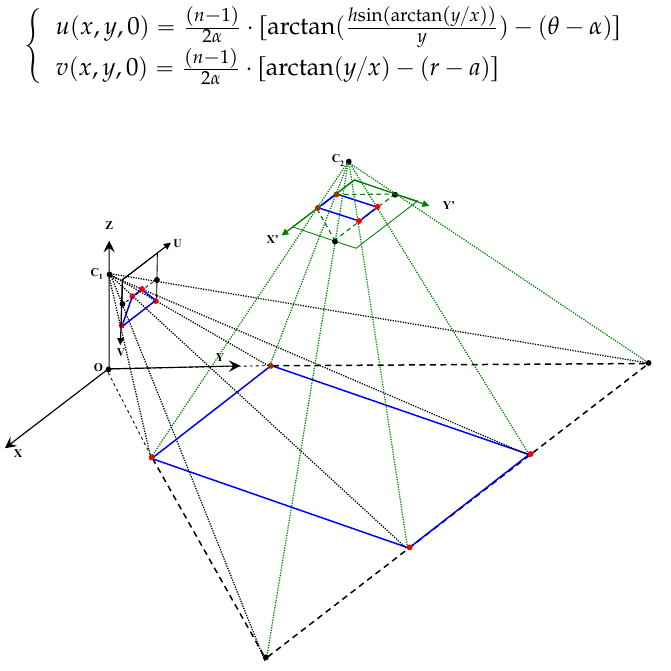
Figure 5. Perspective mapping and top-view mapping.